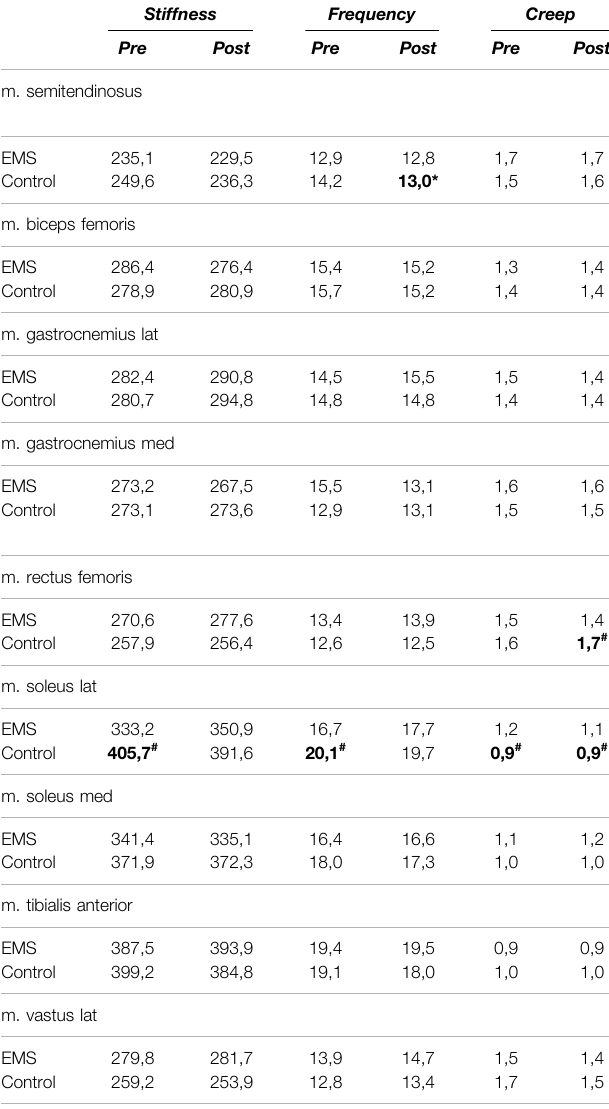
TABLE 1 | Comparative table of the main parameters of skeletal muscle tone properties in two groups of patients. Stiffness Frequency